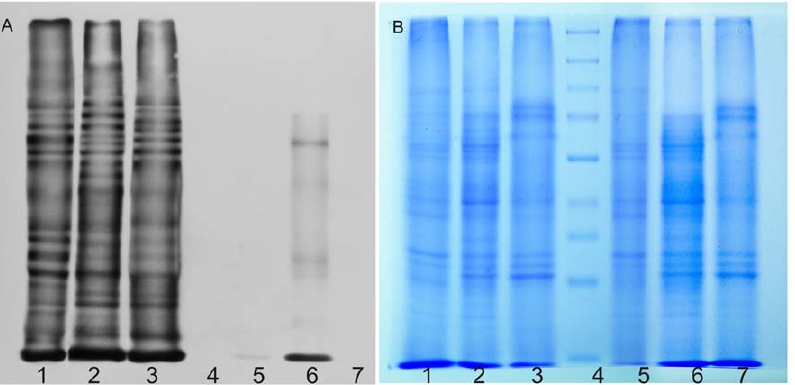
Figure 7. Detection of S-nitrosylated proteins in A.hypogaea nodules. Bacteroid free nodule extracts of 20, 40 and 80 day were processed as per described in the S-nitrosylated protein detection assay kit of Cayman Chemicals, Ann Arbor, Michigan with slight modification. Gel profile of the blot is representative of results obtained from the analysis of three independent experiments. (A) Lane 1, 2 and 3 depict reduced and biotinylated samples of 20, 40 and 80 day old nodule extracts. Lane 4 represents the marker. Lane 5, 6 and 7 represent the endogenously biotinylated protein profiles correspond to lanes 1, 2 and 3. (B) is the corresponding gel profile of blot (A).